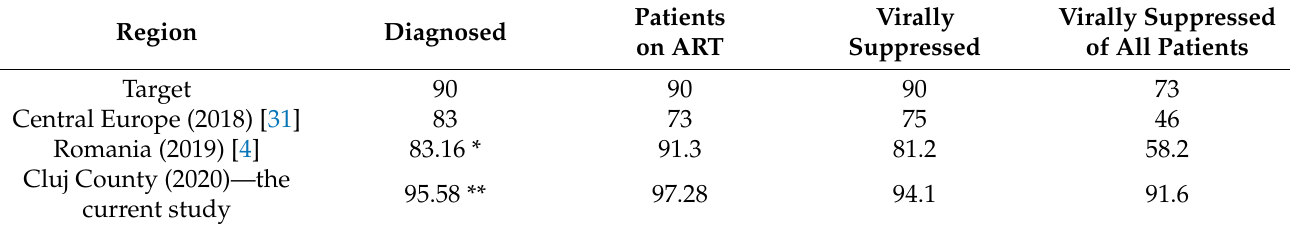
Table 4. WHO’s targets for Central Europe, Romania, and Cluj